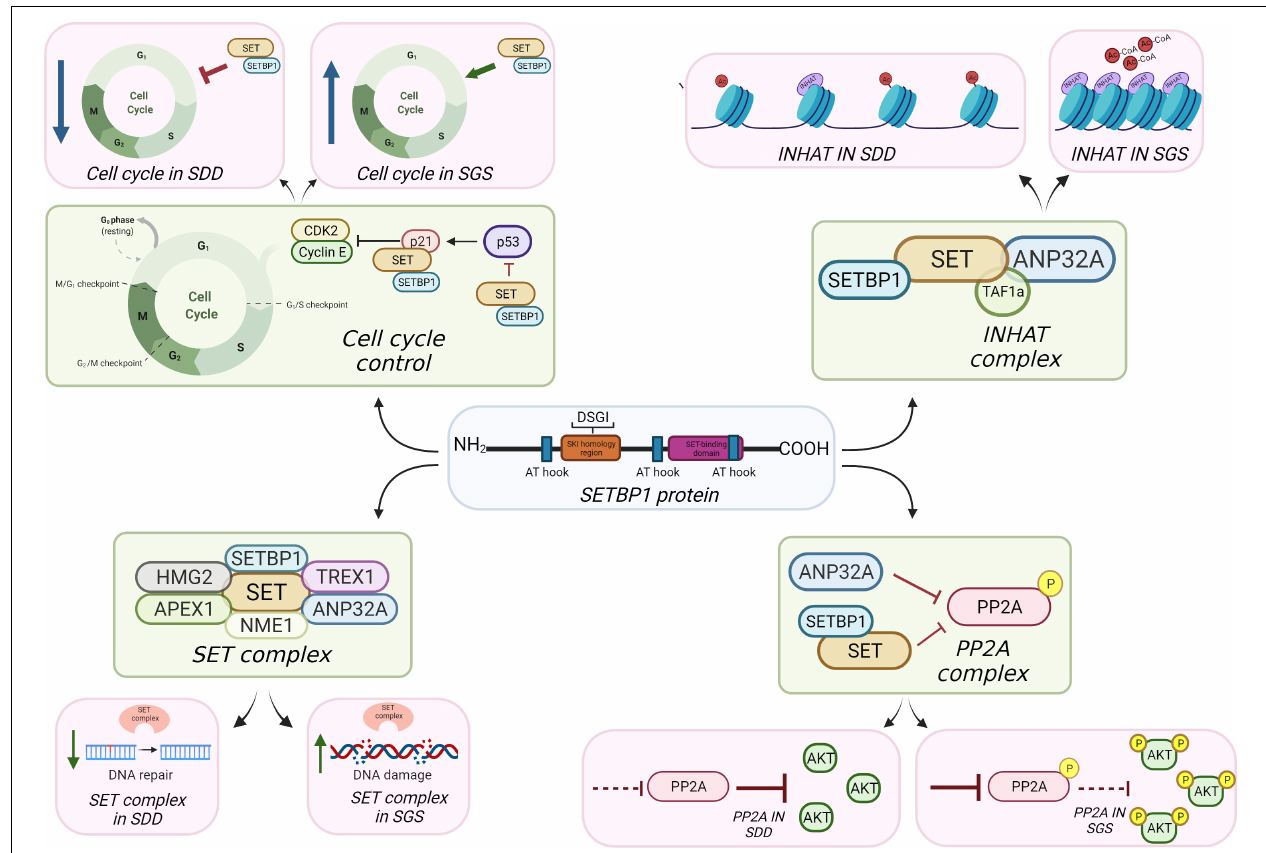
FIGURE 1 | Potential mechanisms of SETBP1 action in